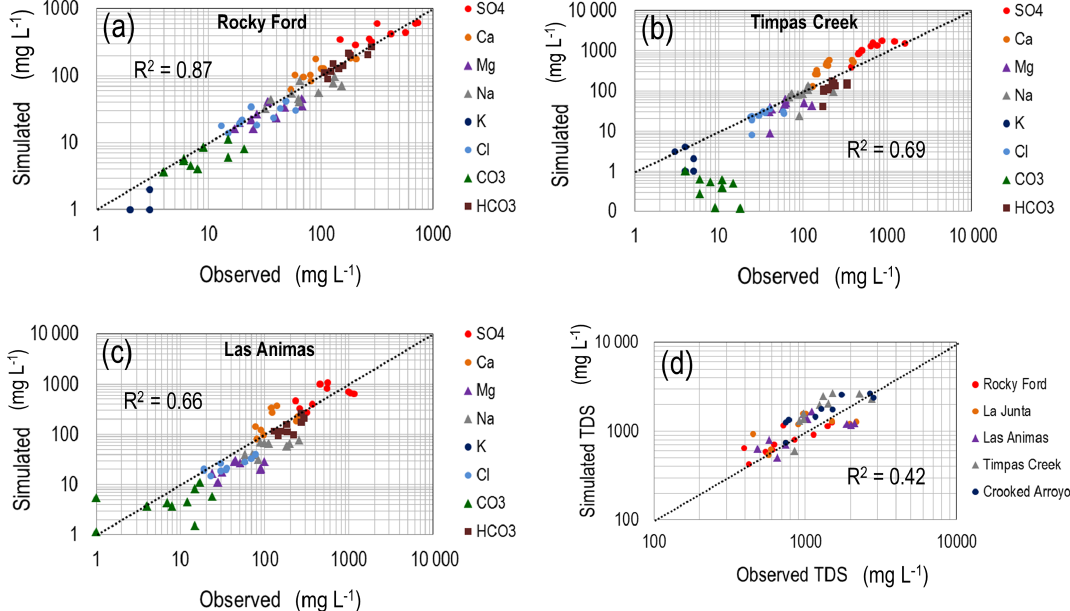
Figure 8. Log–log plots of observed vs. simulated salt ion concentration for the (a) Rocky Ford, (b) Timpas Creek, and (c) Las Animas surface water sampling sites. (d) shows the comparison of TDS for the five